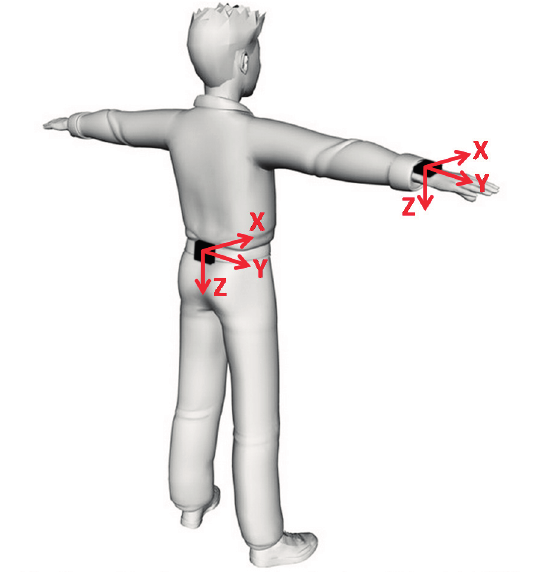
Figure 1. MIMU location and ULF orientation during the static postures (corresponding to the selected GGF): X axis, antero-posterior and positive forward; Y axis, medio-lateral and positive to the right; Z axis, vertically aligned with the direction of the gravitational field vector and positive